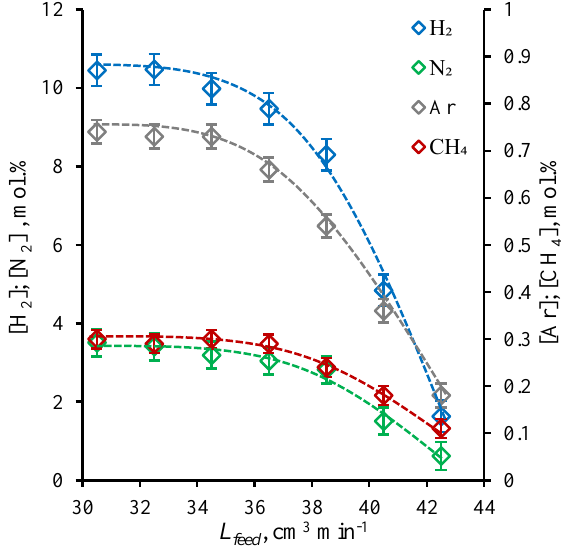
Figure 7. The H 2 , N 2 , Ar, and CH 4 concentration (mol%) in permeate flow under H 2 /N 2 mix sweep of cell’s bore as a function of feed flow rate (cm 3 min − 1 ) during a steady-state ammonia capture pro- cess.